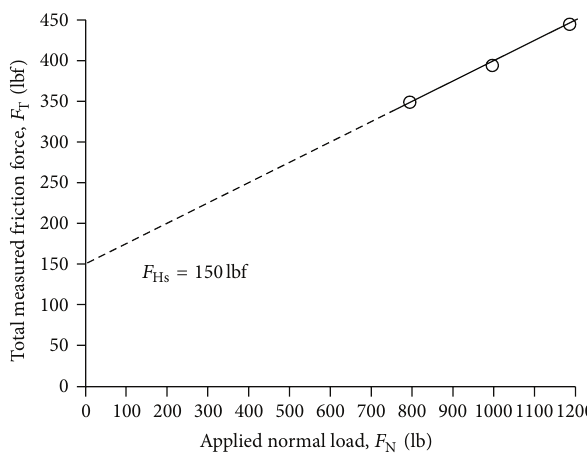
Figure 1: Transportation Research Board [4] Figure A-41 data replotted in accordance with the tire-loading-based approach to sliding-tire-friction-force calculations showing generation of a 150 lbf microhysteretic friction force ( 𝐹 Hs ) and the direct effect of increasing 𝐹 T with increasing 𝐹 N .